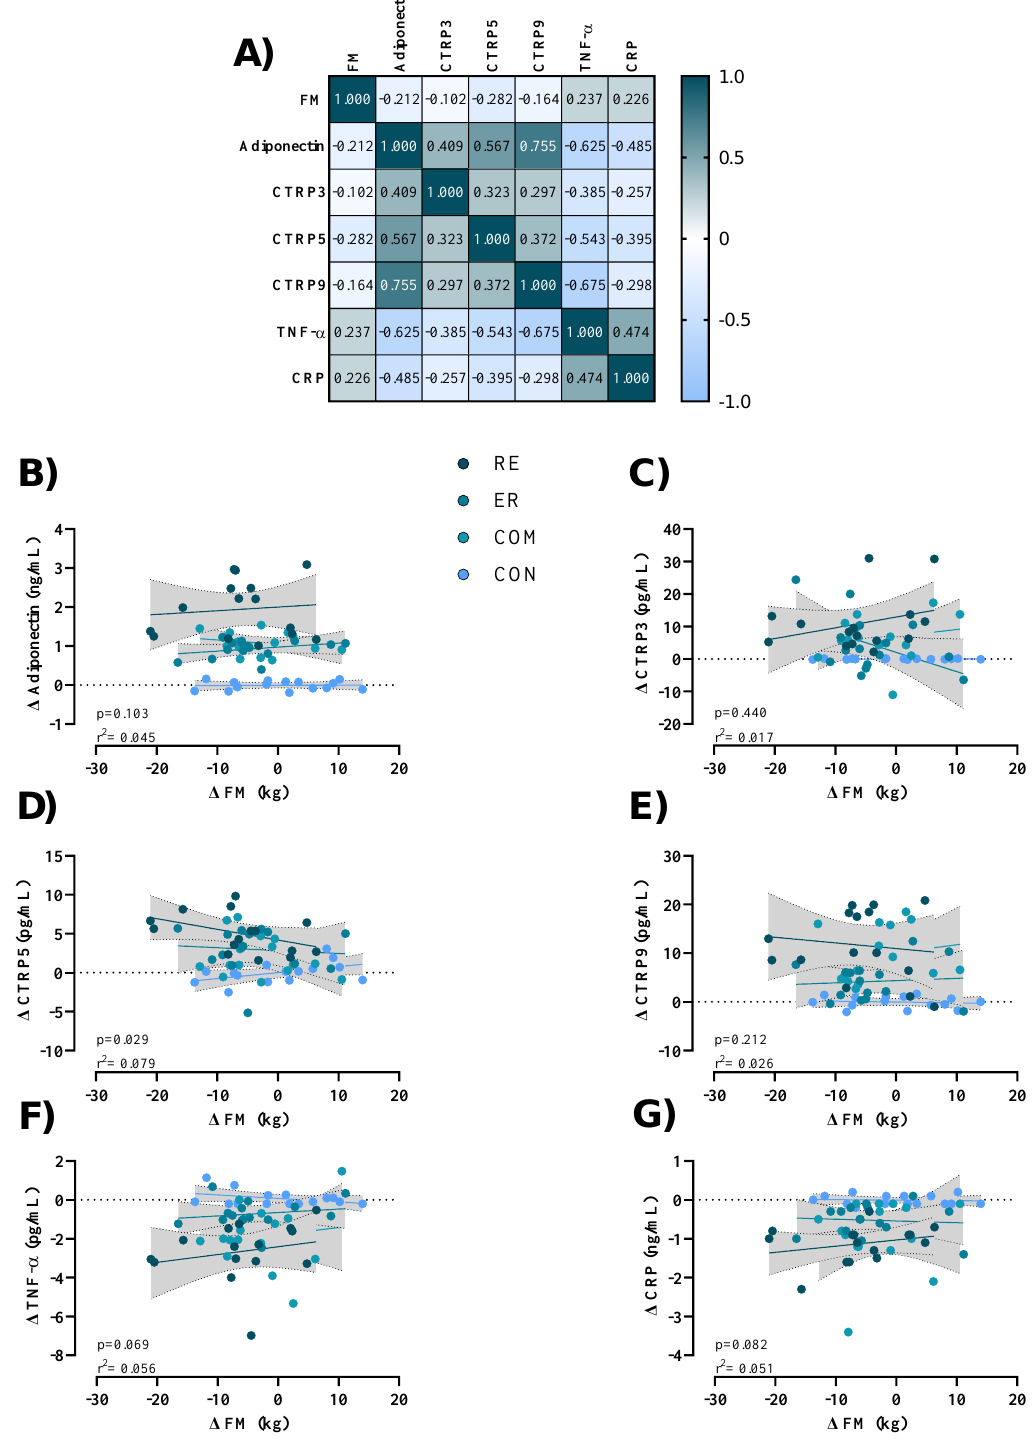
Figure 4. ( A ) Correlation matrix of ∆ FM and serum markers (r-values as shown). The key indicates the magnitude of r (Prussian = − 1 or 1, white = 0). ( B – G ) linear regression (Pearson’s) of ∆ (serum marker) as a function of ∆ FM (kg). The 95% confidence intervals are indicated by grey